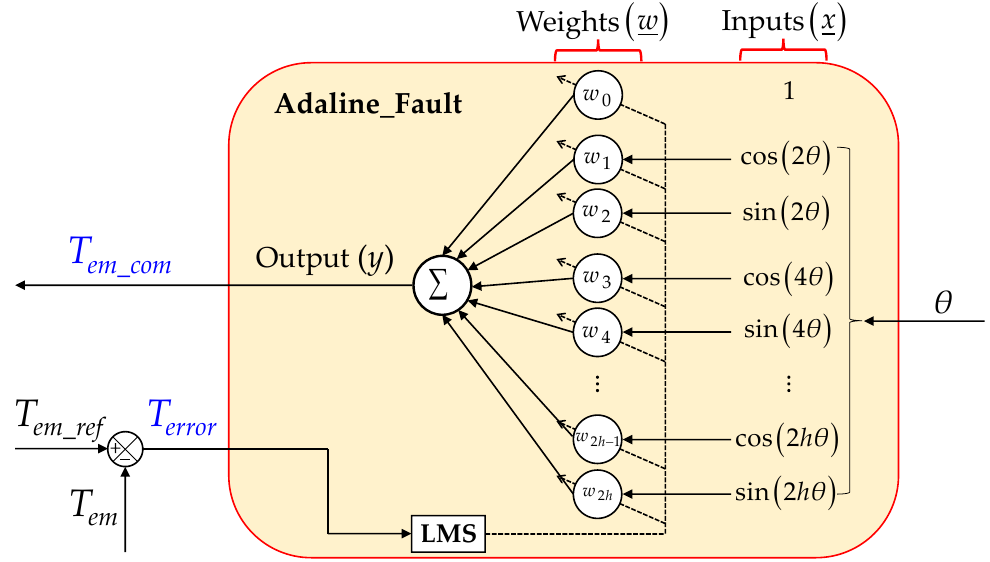
Figure 3. Adaline structure with single layer for the proposed control scheme of a seven-phase PMSM in faulty condition.